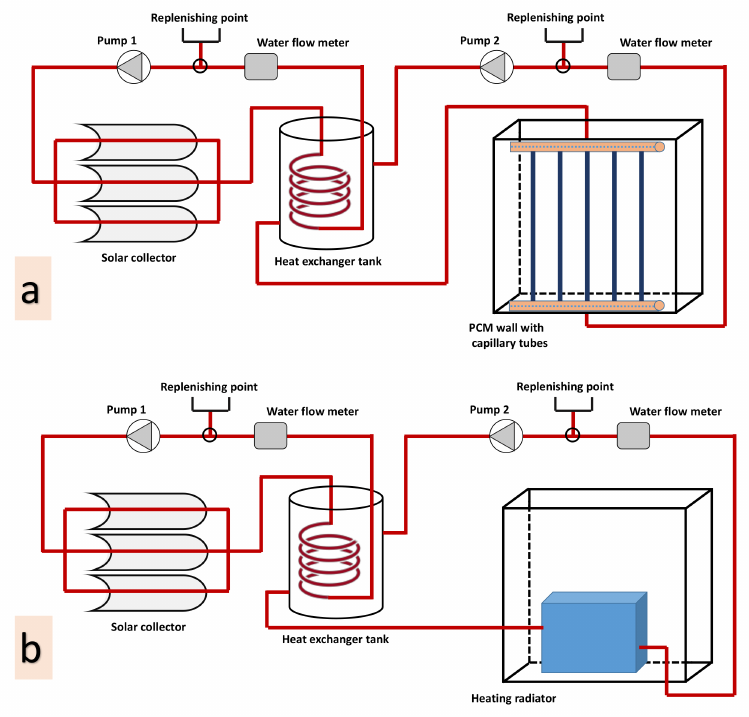
Figure 3. Schematic representation of the studied hybrid system: ( a ) PCM room and ( b ) reference room